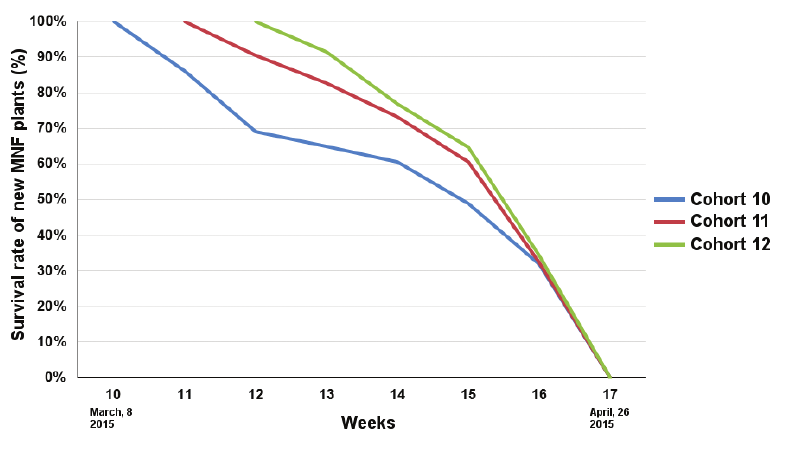
Figure 2. Survivorship of MNF E. dens-canis plants in March 2015. The three major cohorts are shown: Cohort 10 (in blue) with 94 new plants found on March 8 th (week 10); Cohort 11 (in red) with 127 new plants found on March 12 th (week 11); Cohort 12 (in green) with 82 new plants found on March 19 th (week 12).